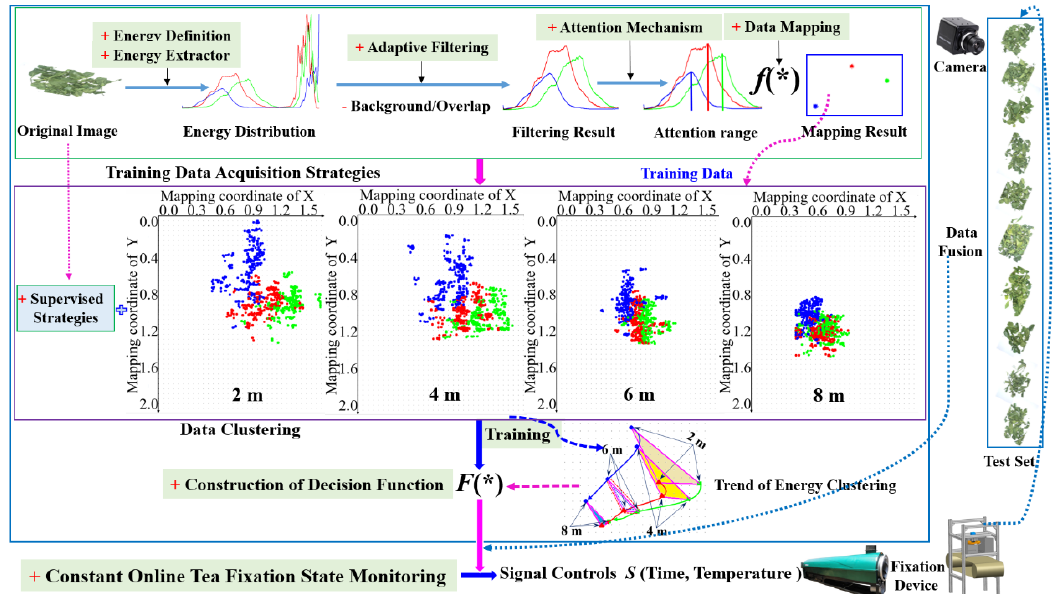
Figure 1. Proposed algorithm detailed steps.